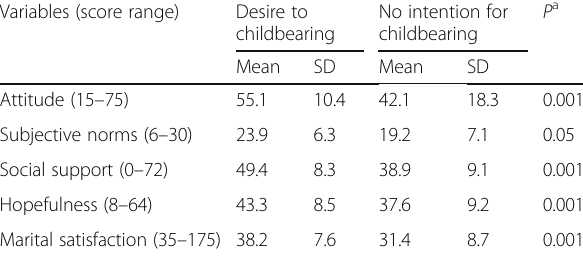
Table 3 The mean scores and standard deviation of psychological factors influencing the childbearing intentions of women Variables (score